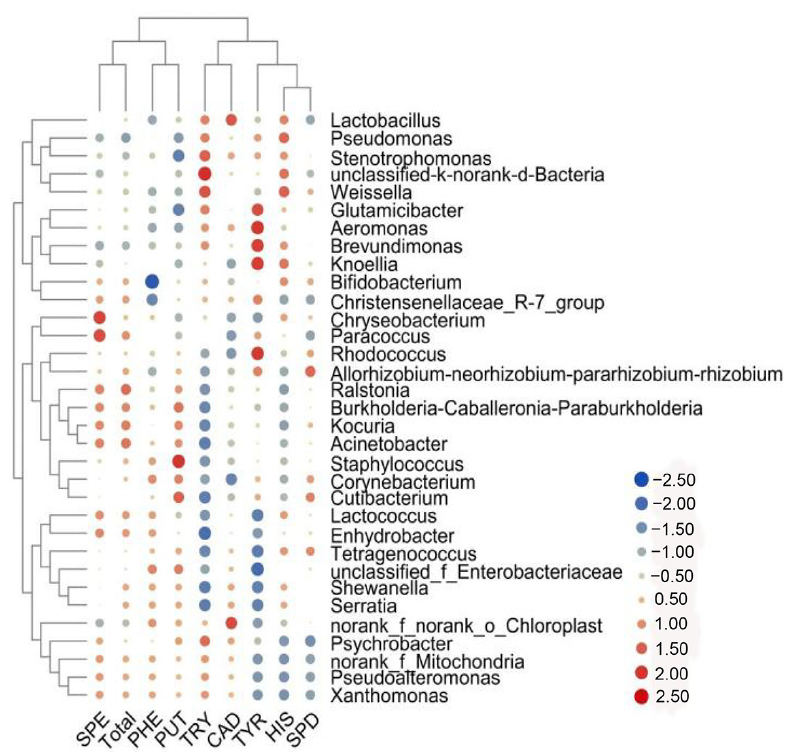
Foods 2022 , 11 , x FOR PEER REVIEW Figure 8. Heat map of the correlation between biogenic amines and microorganisms of beef jerky. By calculating and measuring the VIP values, we were able to determine the explan- atory power of each microorganism with respect to the formation of BAs. Seven genera had a VIP value > 1, including Lactococcus , Lactococcus , and Tetragenococcus (Figure 9), which suggests that they have significant effects on amine production.